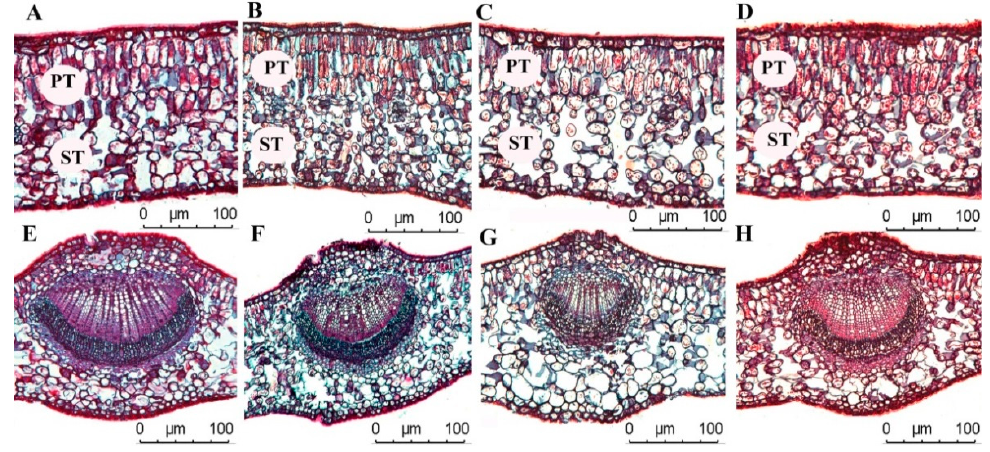
Figure 2. Anatomical characteristics of C. oleifera leaves under different light regimes. Note that CK: 100% light regime ( A , E ); HL: 75% light regime ( B , F ); ML: 50% light regime( C , G ); LL: 30% light regime ( D , H ).